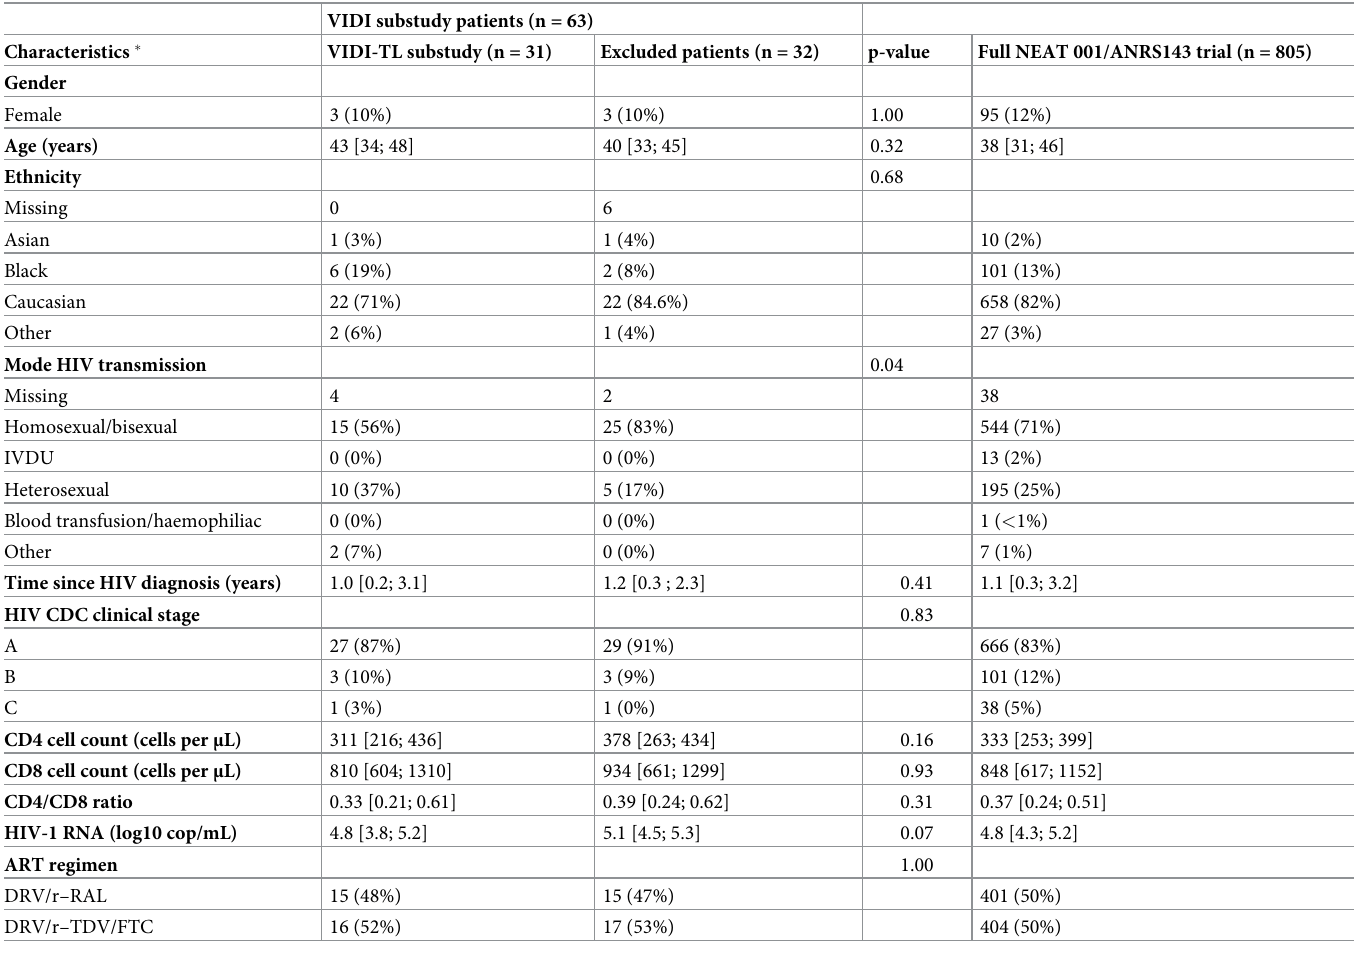
Table 1. Characteristics at baseline of the participants from the NEAT-VIDI substudy (n = 31) and NEAT 001/ANRS 143 trial (n = 805). VIDI substudy patients (n =